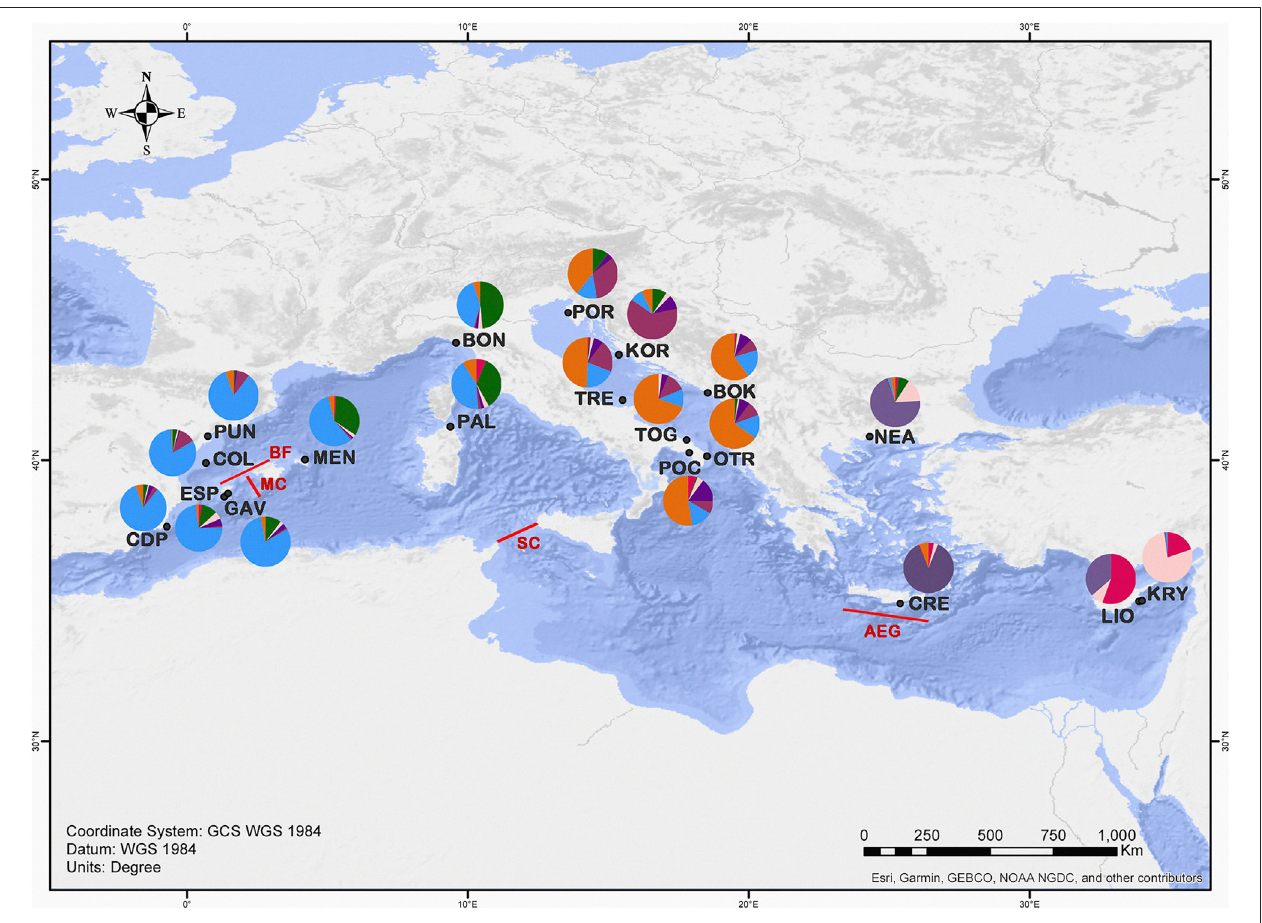
FIGURE 1 | Map showing the locations of the sampled populations of C. caespitosa in the Mediterranean Sea. The main barriers detected in our analyses are indicated in red: MC, Mallorca Channel; BF; Balearic Front; SC, Sicily Channel and AEG, Aegeant Front (Ruiz et al., 2009; Pascual et al., 2017). Pie diagrams show a summary of the STRUCTURE results for K = 7 (colours as in Figure 5 ), in terms of the proportion of the identi fi ed genetic clusters assigned to each site.